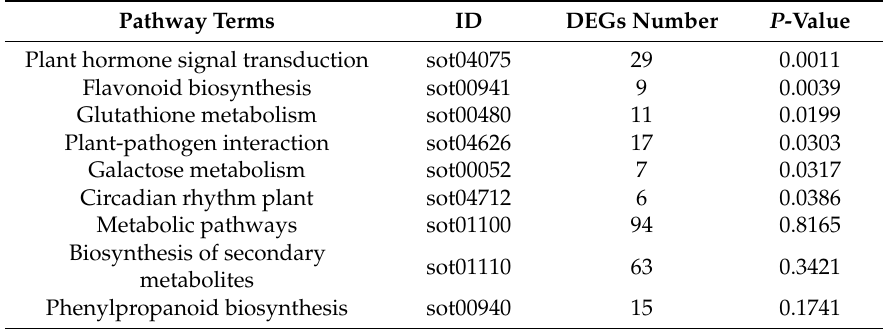
Table 2. Main Kyoto Encyclopedia of Genes and Genomes (KEGG) pathways enriched in differentially expressed genes in P3-198.